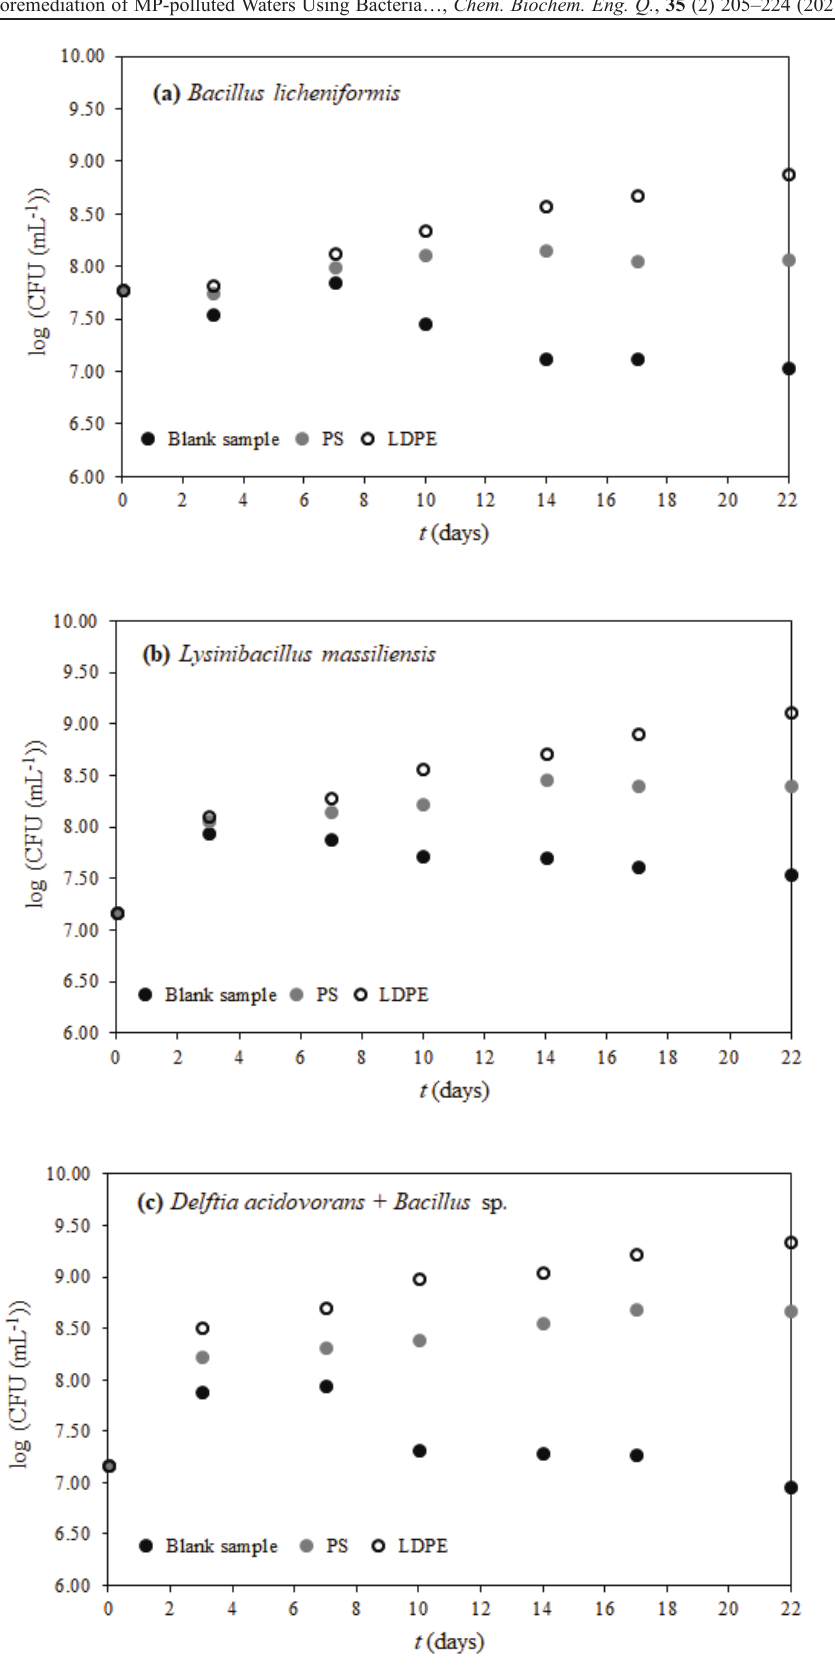
Fig. 3 – Changes in CFU during biodegradation of MP-LDPE and MP-PS with bacterial culture Bacillus licheniformis (a), Lysini- bacillus massiliensis (b), and mixed bacterial culture of Bacillus sp. and Delftia acidovorans (c) in sterile Erlenmeyer flasks during 22 days (Vr = 100